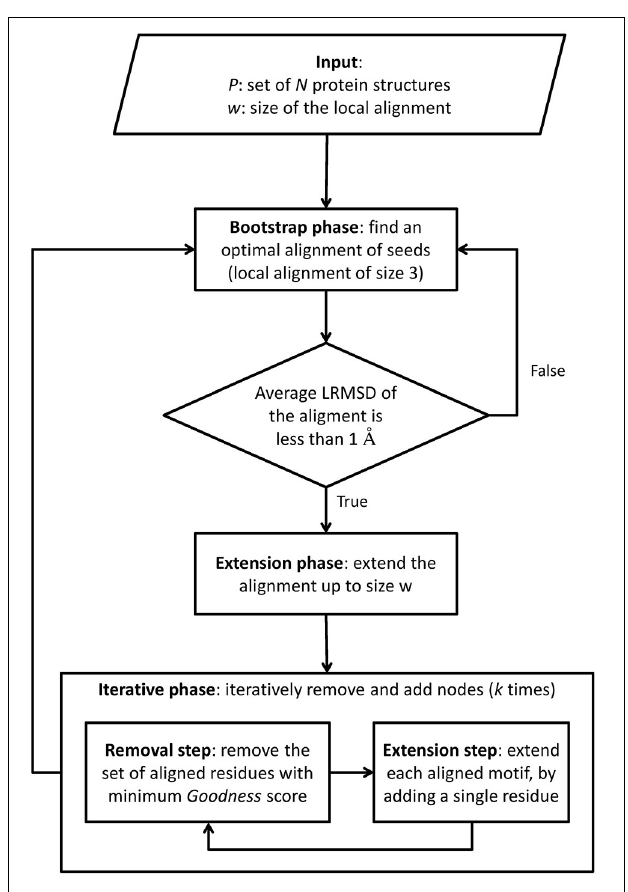
FIGURE 1 | Outline of PROPOSAL.